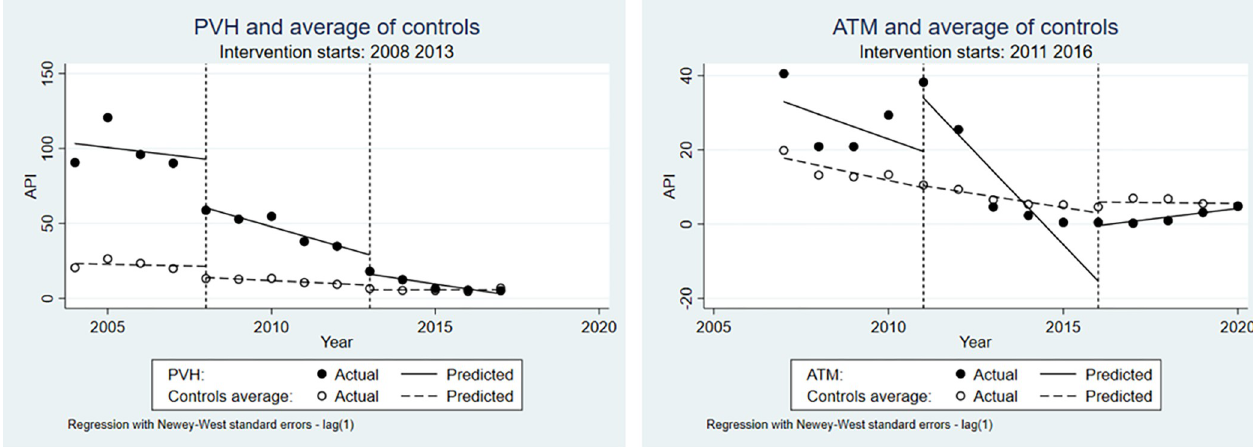
Fig 3. Interrupted time-series regression analysis of malaria annual parasite index (cases per 1,000 inhabitants) in each study site, PVH and ATM (black dots and solid lines) and Amazon as control (open dots and dashed lines) before, during and after the dams’ construction. The vertical dashed line separates pre- and post- “intervention”, in this case the start and end of the dam’s construction. The construction in PVH starts in 2008 and ends in 2013, while in ATM it starts in 2011 and ends in 2016.